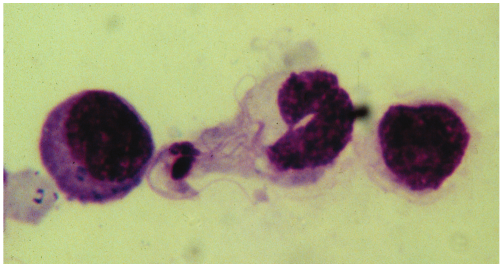
Figure 7: Peritoneal macrophage in the ascites of an experimentally infected rainbow trout, Cryptobia salmositica in the process of being ingested (reproduced from Woo